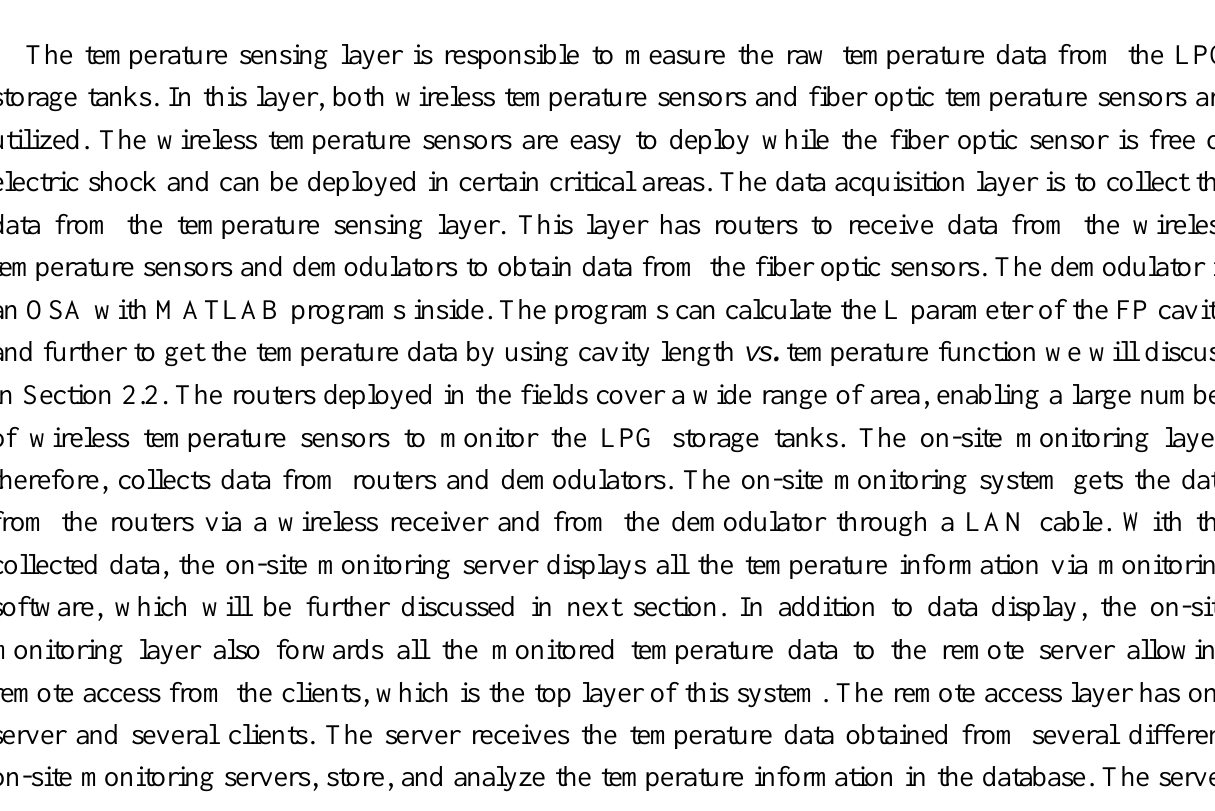
Figure 1. Hardware design for the monitoring